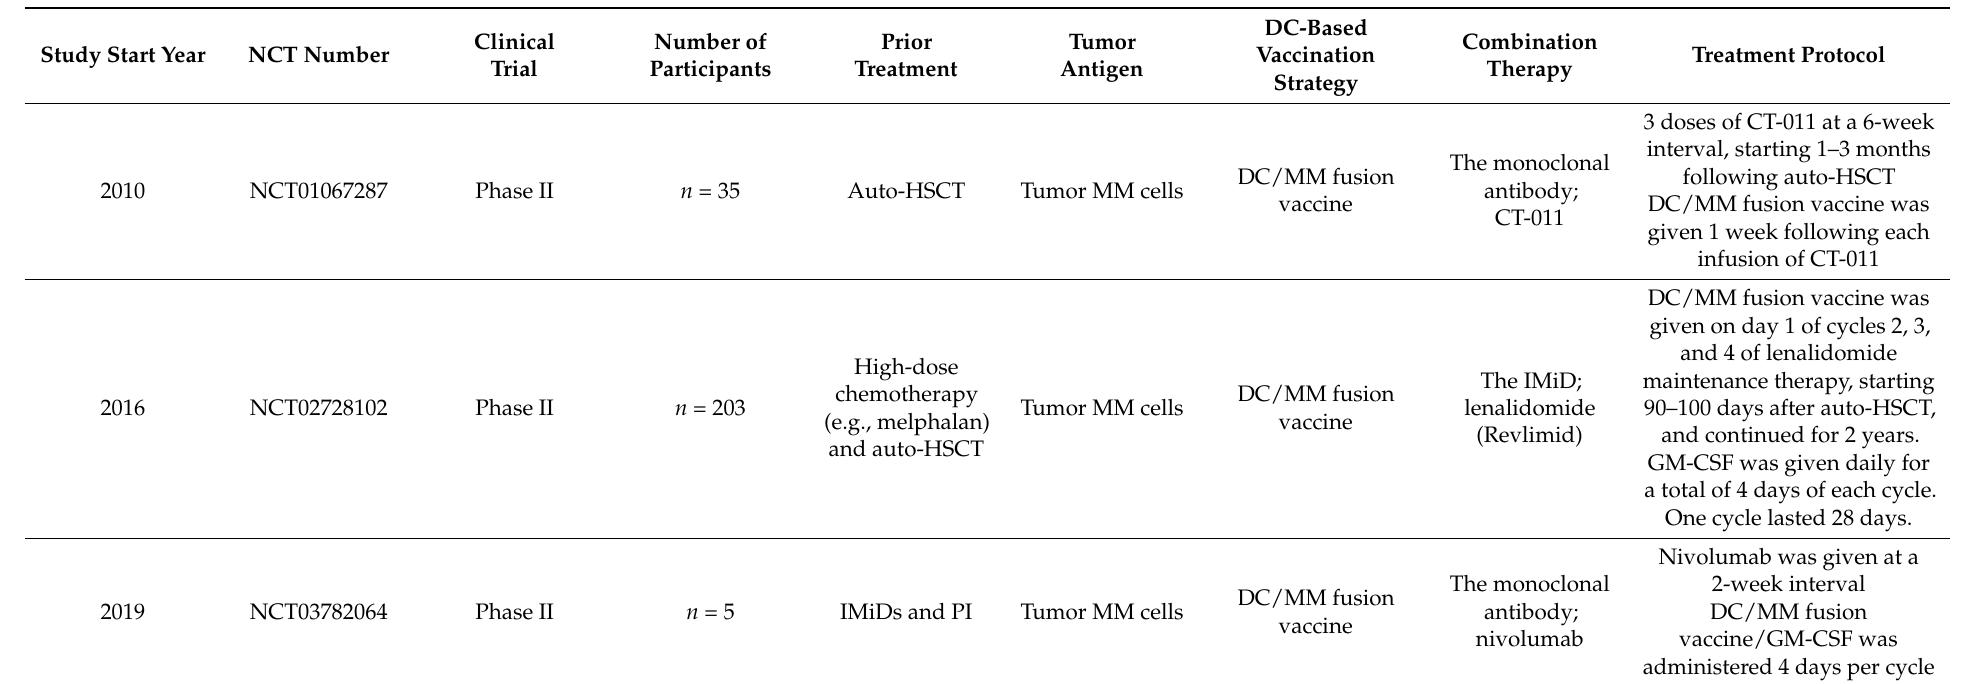
Table 2. Overview of clinical trials using DC-based combination strategies in MM